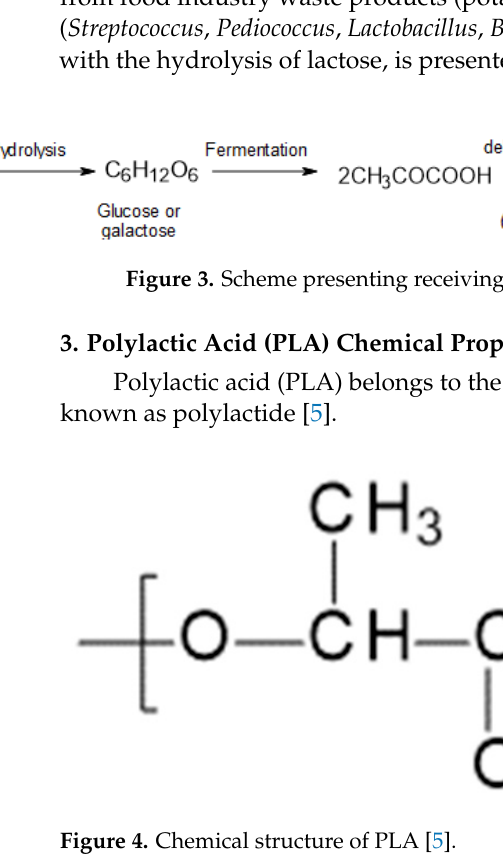
Figure 4. Chemical structure of PLA [5].